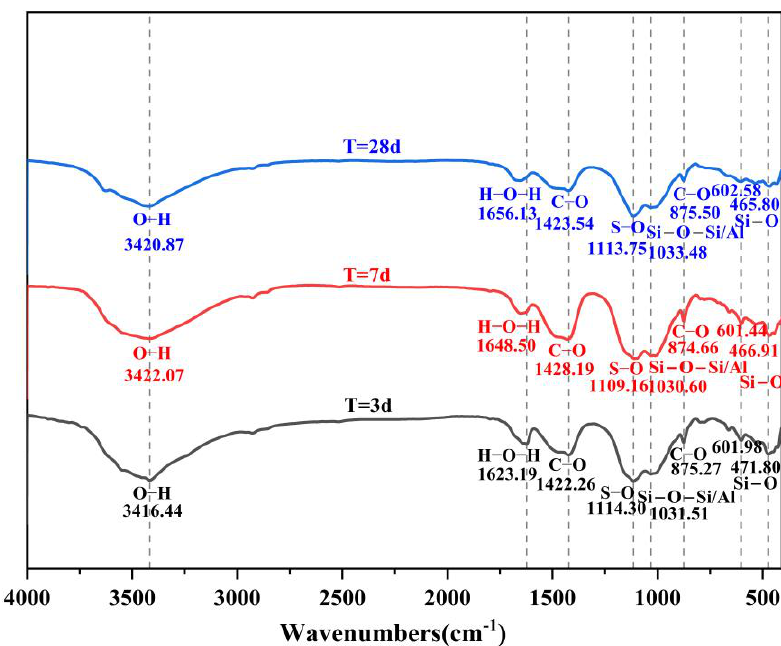
Figure 7. FTIR patterns of MS7 sample.